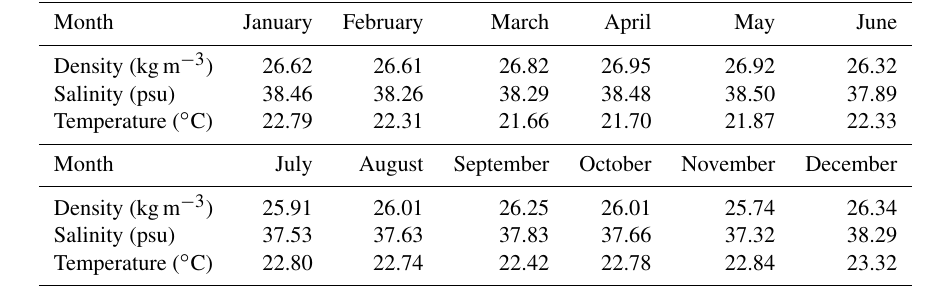
Table 1. Maximal PGW density and associated salinity and temperature, before cascading in the Sea of Oman for each month extracted from the GDEM climatology.